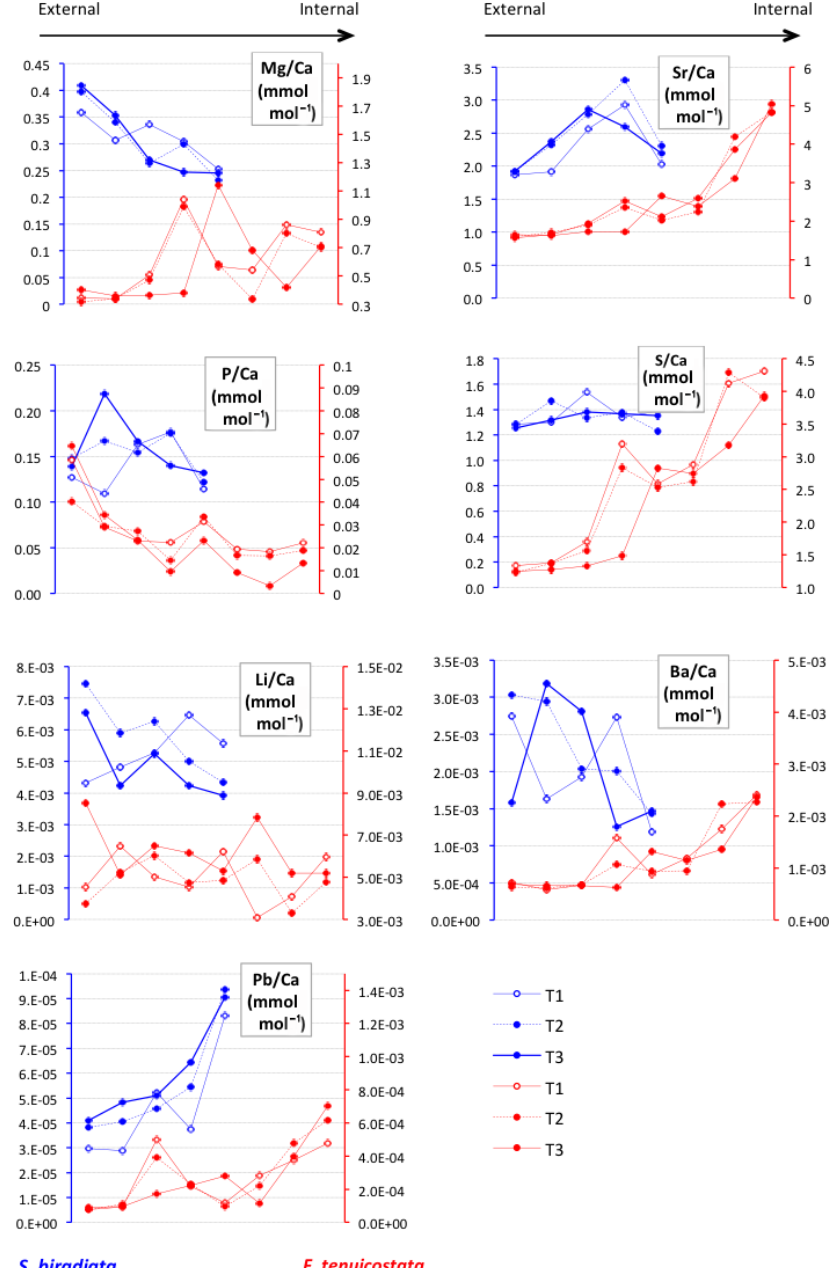
Figure 10. The LA-ICP-MS results for transects T1, T2 and T3. The blue lines represent the results for S. biradiata (G171) and the red lines represent the results for F. tenuicostata (G155). The five laser spots or transects were done on